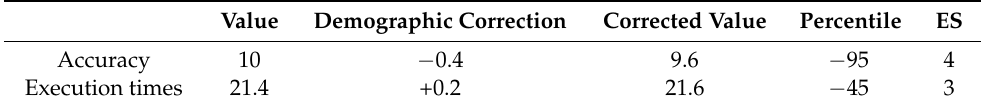
Table 14. Example 1 of application of GVT in one case: scoring.